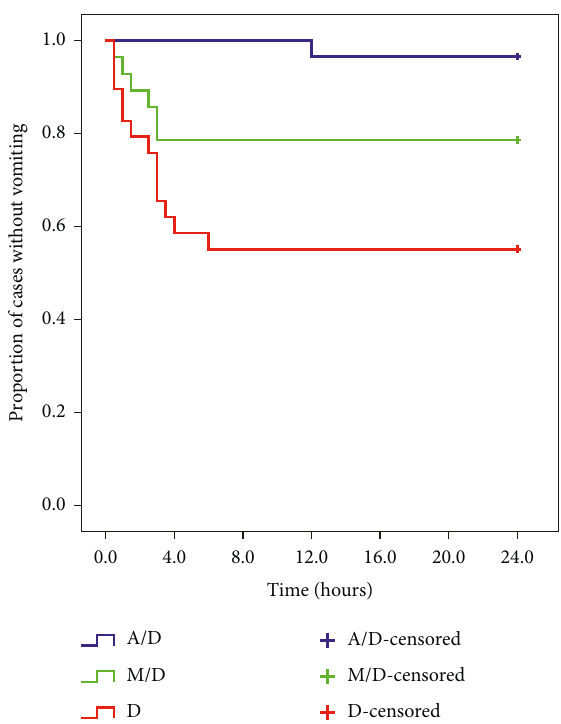
Figure 2: Kaplan–Meier curve for vomiting rate (Log rank test, P value 0.001). A/D group: aprepitant/dexamethasone group, M/D group: mirtazapine/dexamethasone group, and D group: dexa- methasone group. <